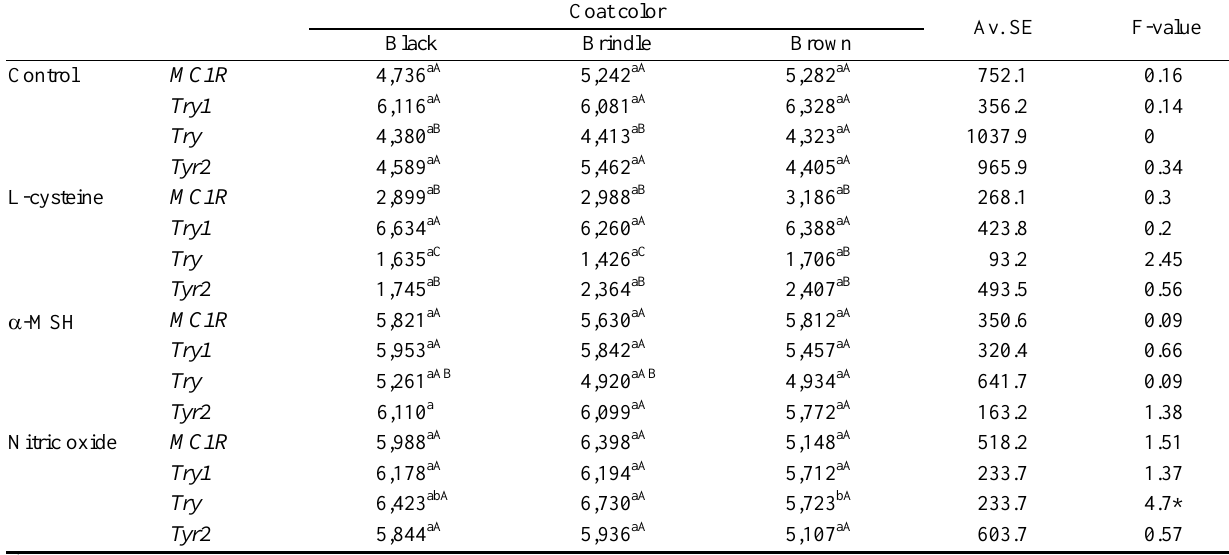
Table 2. mRNA expression of MC1R , Try1 , Try2 and Try genes in arbitrary unit for melanocytes from Black, Brindle and Brown Hanwoo muzzles treated with L-cysteine,  -MSH and Nitric oxide